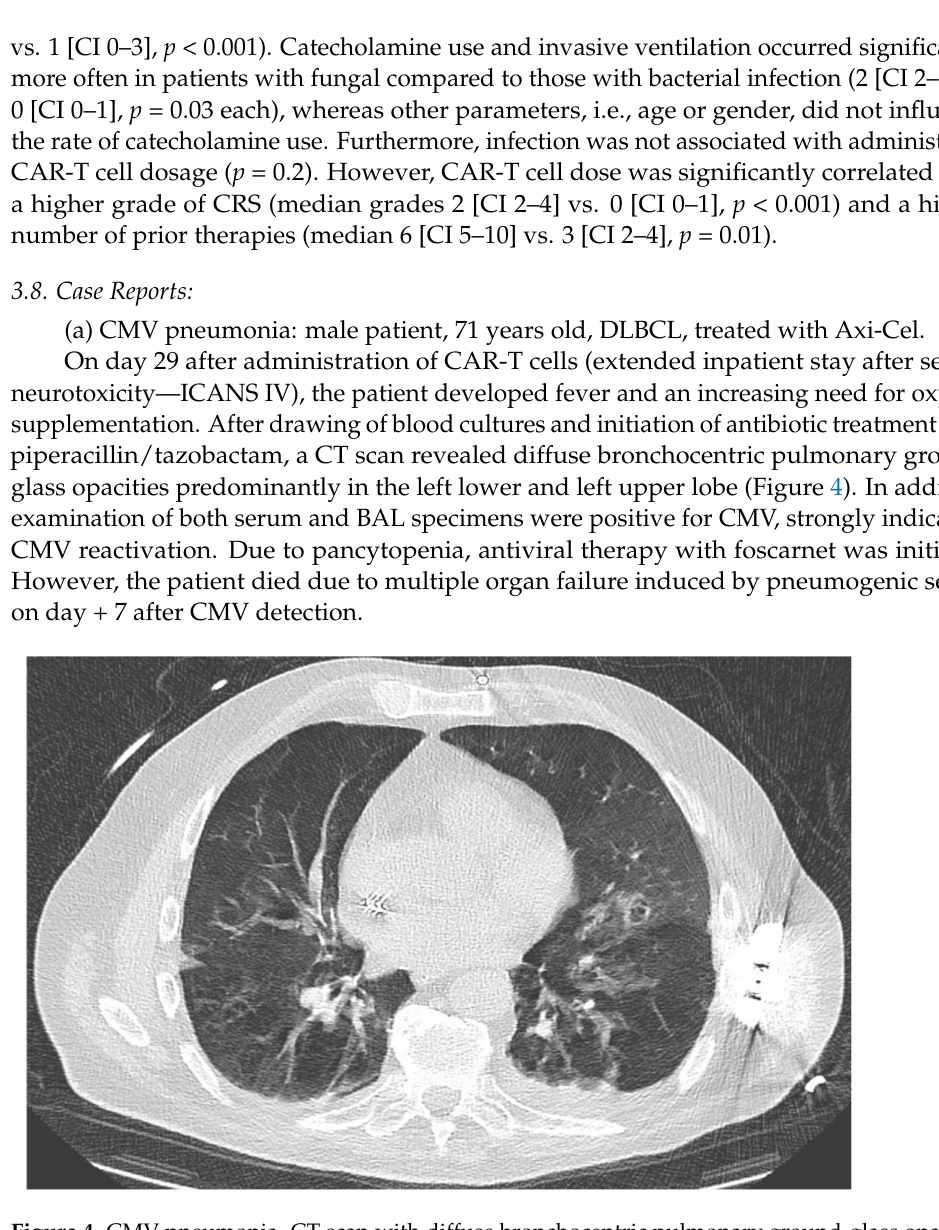
Figure 4. CMV pneumonia. CT scan with diffuse bronchocentric pulmonary ground-glass opacities predominantly in the left lower and left upper